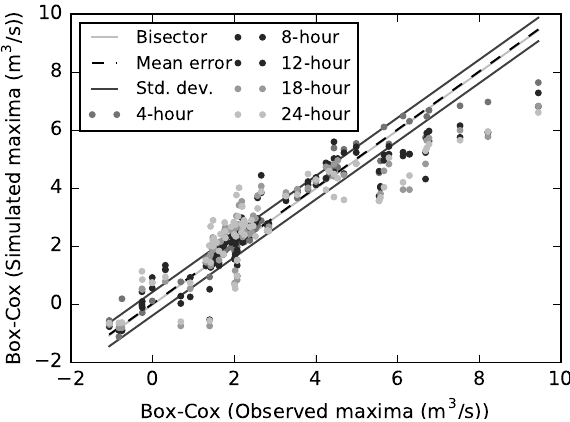
Figure 10. Comparison of nearly independent peak flow maxima for forecasting models of 4, 8, 12, 18 and 24